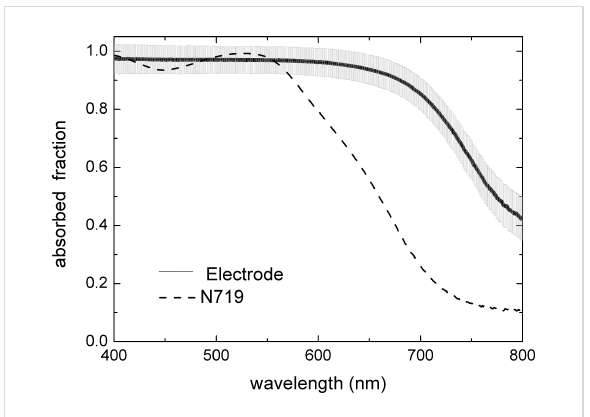
Figure 2: Absorbed light fraction of a PA calculated from experimental reflectivity and transmissivity spectra (continuous line), and of the solu- tion containing the same dye load (dashed line).